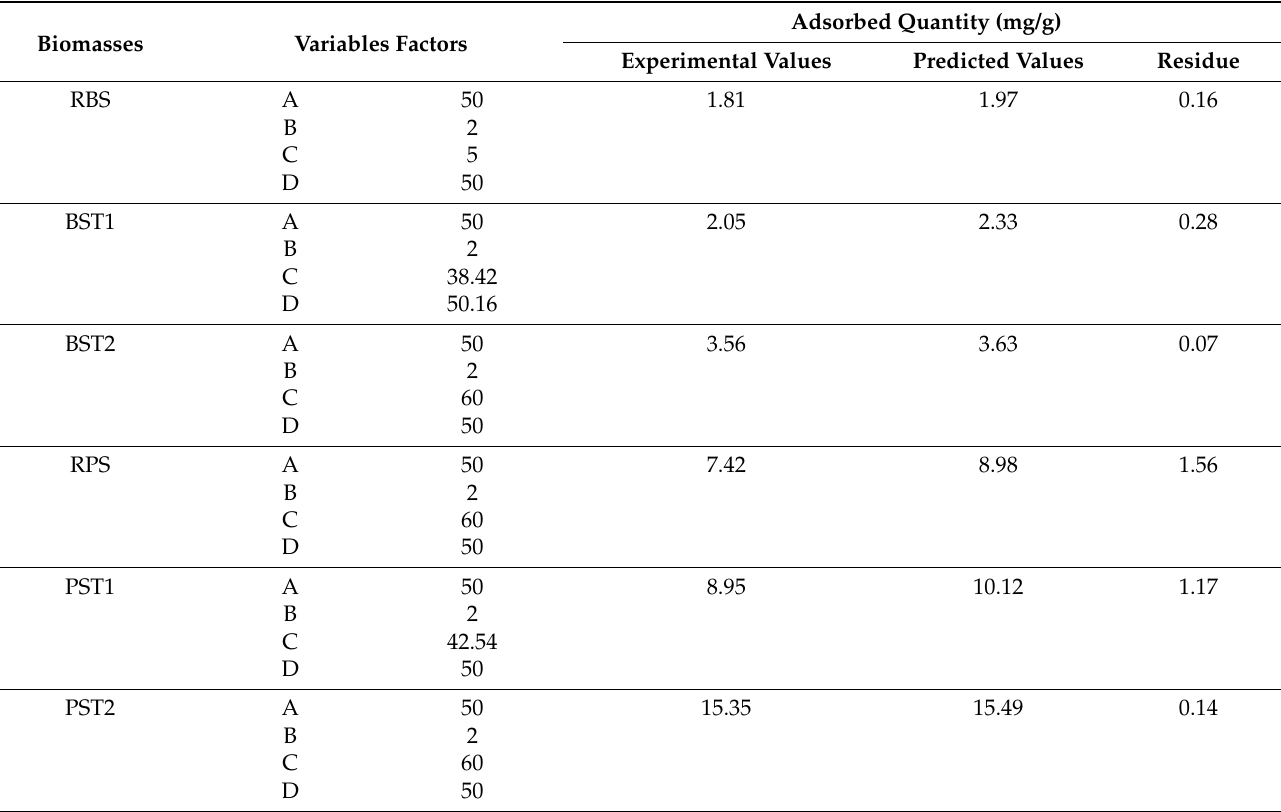
Table 4. Validation of the experimental model of IC adsorption by the different biomasses (RBS, BST1, BST2, RPS, PST1, and PST2). Adsorbed Quantity (mg/g) Biomasses Variables Factors Experimental Values Predicted